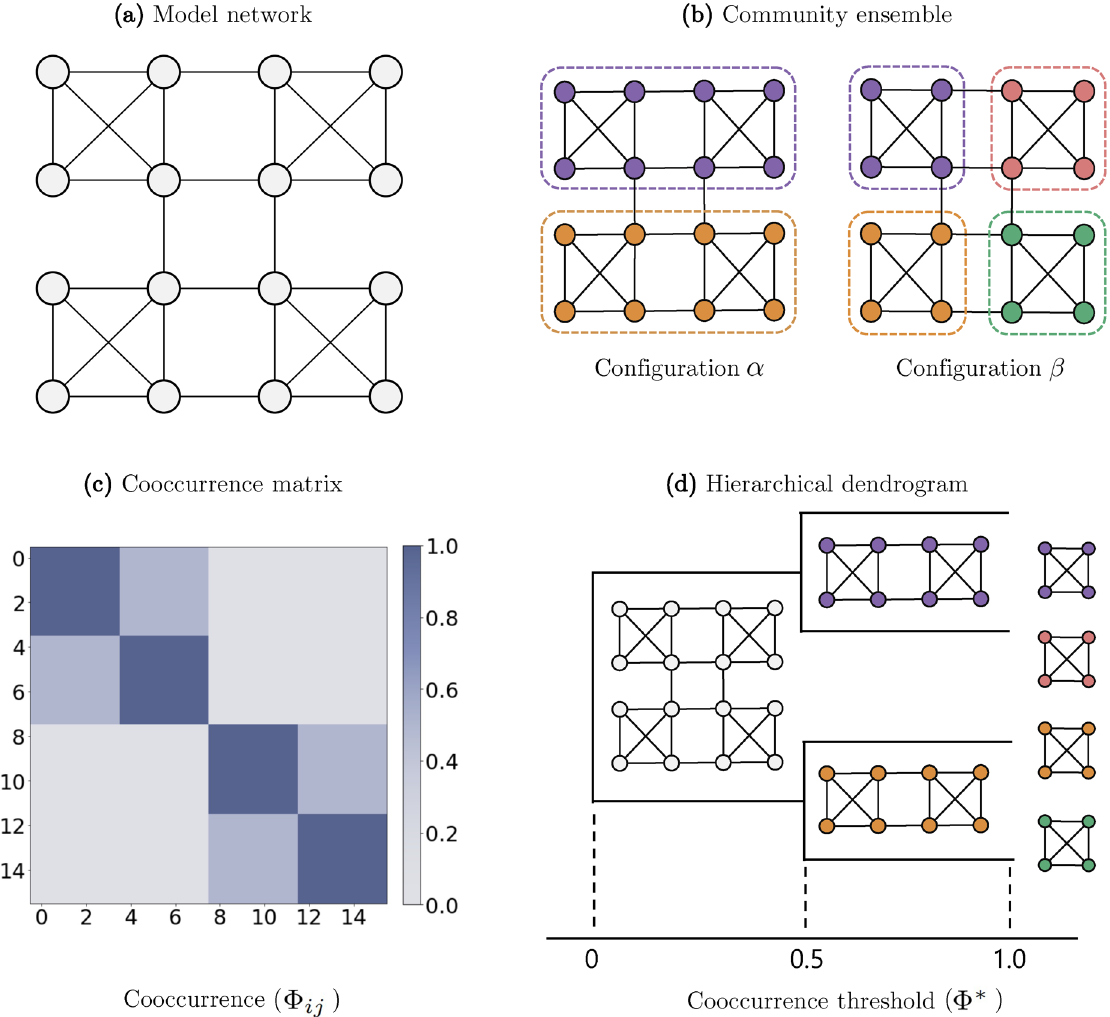
Figure 1. An illustrative example of the hierarchical decomposition analysis. ( a ) A representation of the model network of size 16. ( b ) A representation of the two configurations in the community ensemble of the model network. ( c ) A cooccurrence matrix constructed from the ensemble. The blocks are colored dark blue, light blue, and gray for (cid:31) ij = 1 , 0.5 and 0 respectively. ( d ) A dendrogram built by the hierarchical decomposition. The horizontal axis refers to the cooccurrence threshold (cid:31) ∗ . For each merging point of branches, a configuration of the corresponding component is